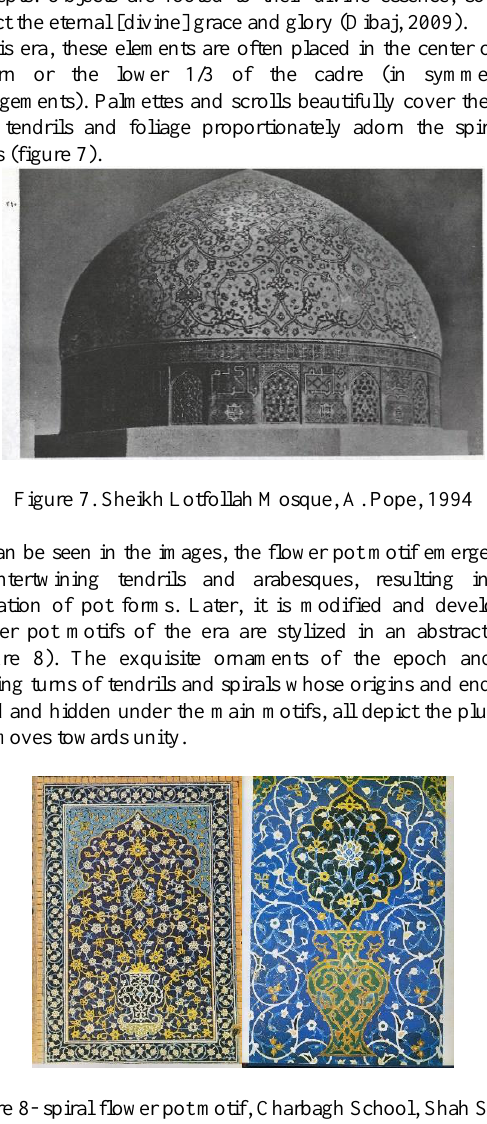
Figure 8- spiral flower pot motif, Charbagh School, Shah Sultan